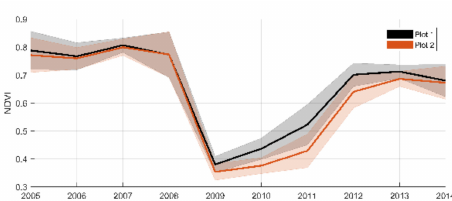
Figure 8. Landsat-derived summertime Normalized Di ff erence Vegetation Index (NDVI) from 2005 to 2014, covering both pre- and post-harvest conditions at both plots. The shaded bands represent the standard deviation of the spatially (nine pixels) and temporally (all available Landsat images during the summer (JJA) of each year) averaged data used to create an annual, summertime,